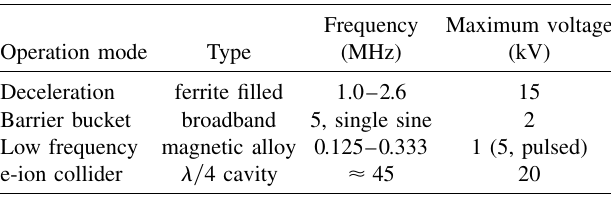
TABLE IV. The rf systems of NESR.